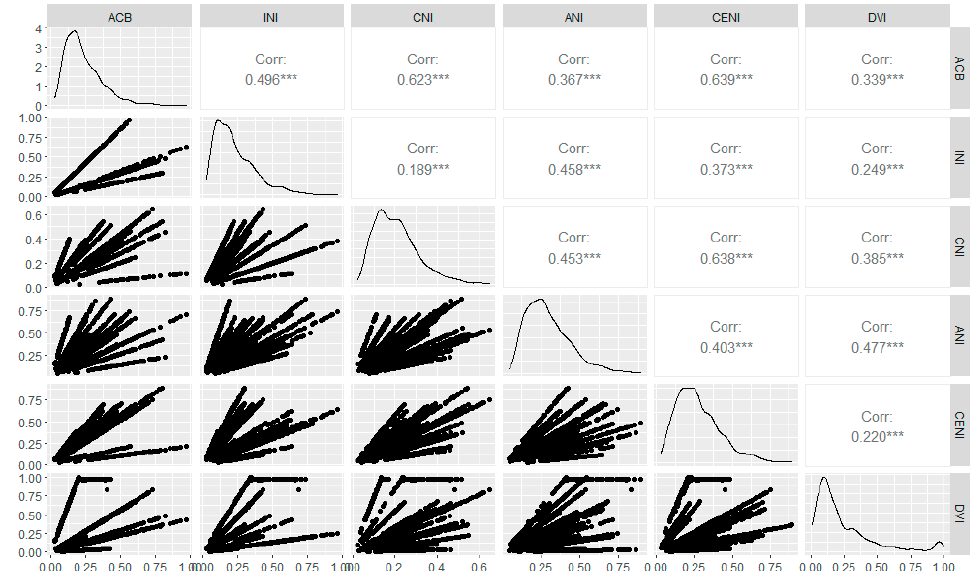
Figure 5. Correlation matrix between RPF factors and Composite Index of Online Purchasing Be- havior as of June 2020. Source: developed by the authors. *** p ≤ 0.001.